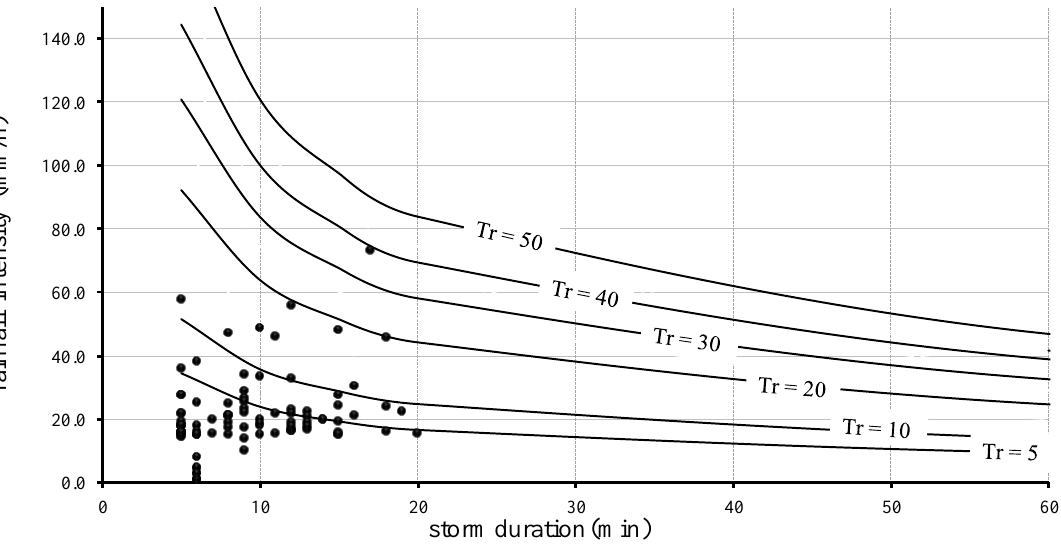
Figure 1. Traditional representation of an intensity–duration–frequency (IDF) curve at station CH-03. k = 51.55; m = 0.53; n = 0.53; θ = 1; C = 0.